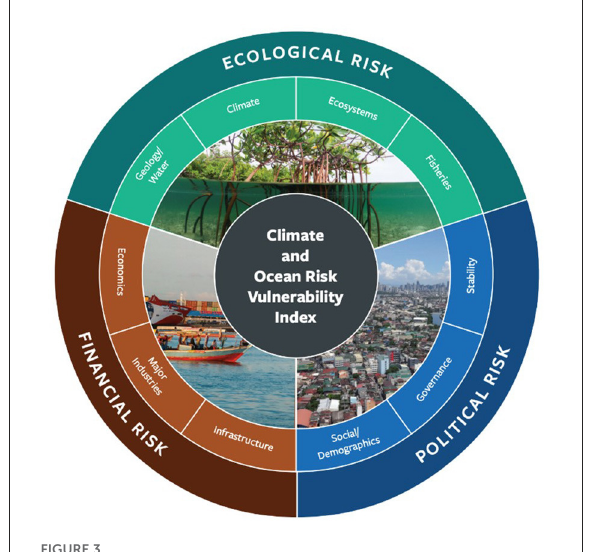
FIGURE3 CORVI risk type and categories.